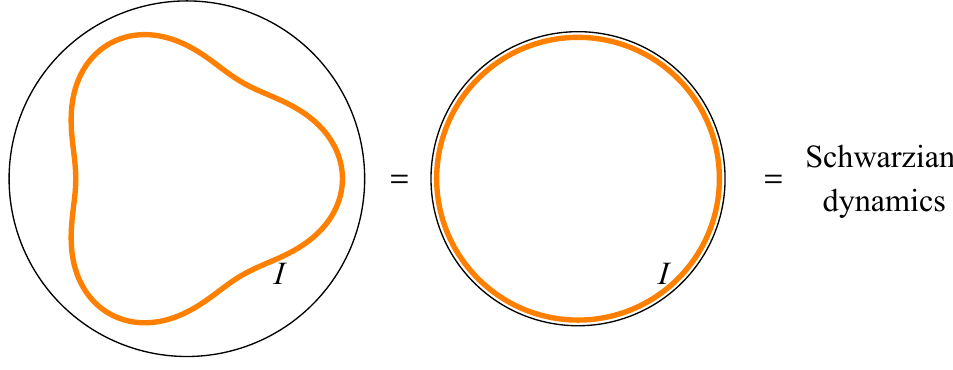
Figure 2 . Cartoon emphasizing the properties of the string defect. The resulting theory is invariant under perimeter preserving defect di(cid:11)eomorphisms and thus the defect can be brought arbitrarily close to the boundary of the manifold. Furthermore, the degrees of freedom of the gauge theory defect can be captured by those in the Schwarzian